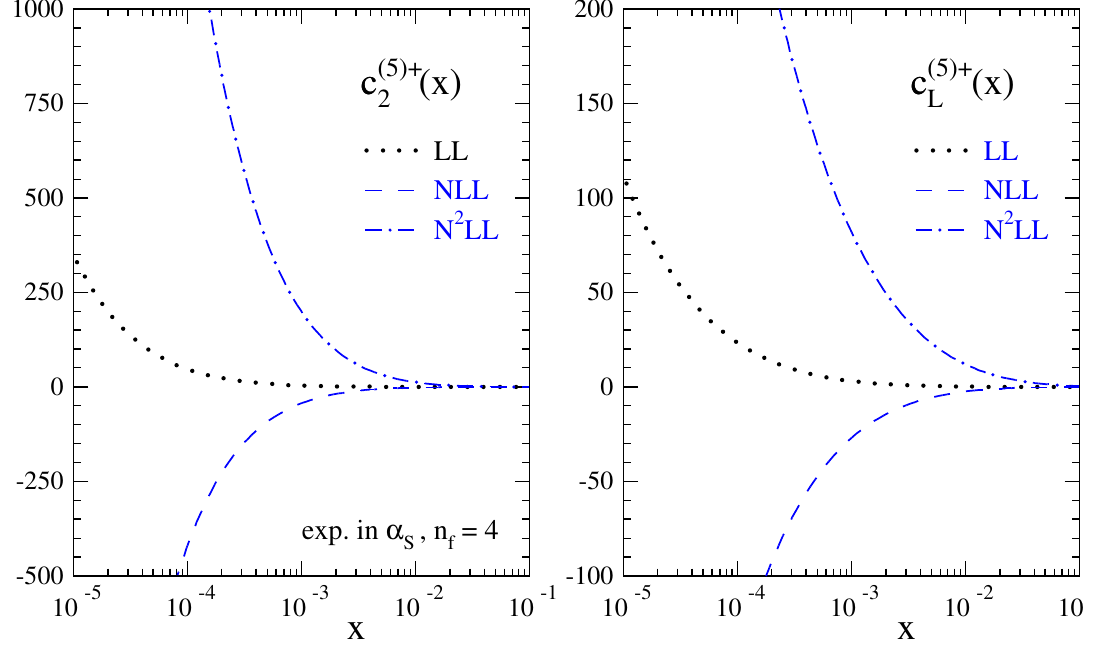
Figure 3 . As figure 2, but for fifth-order coefficient functions for the structure functions F 2 and F L in eq.